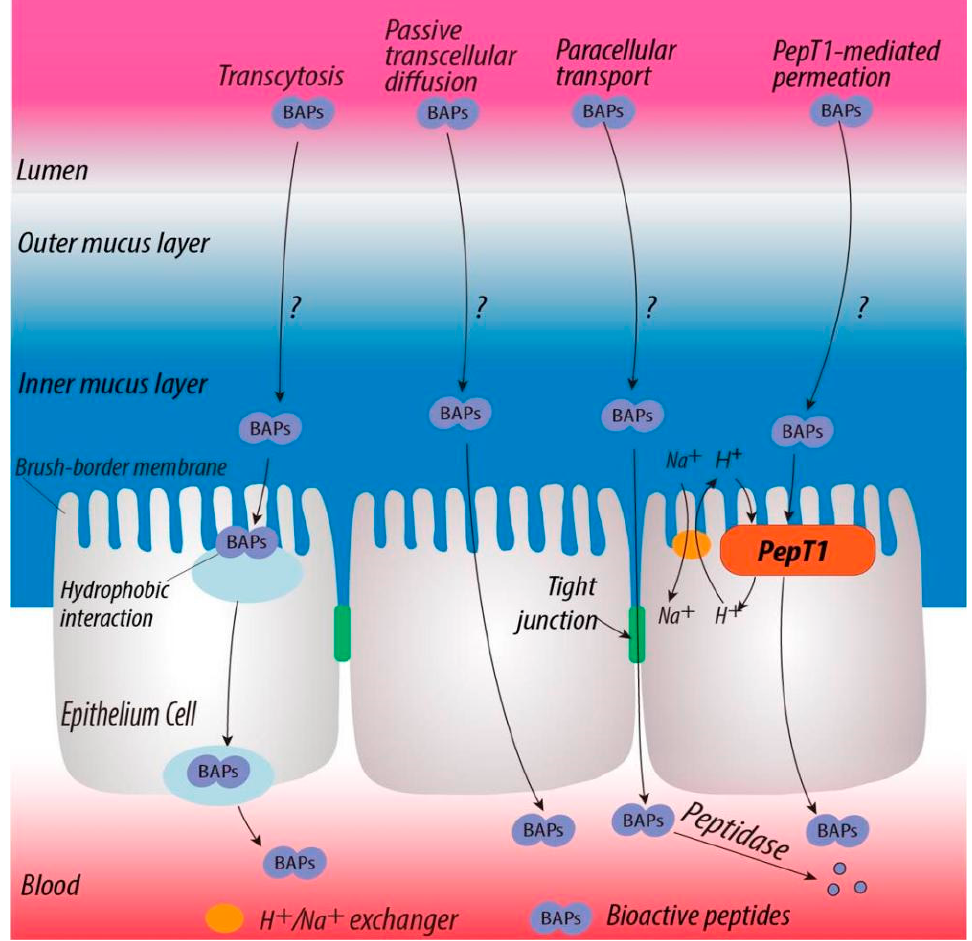
Figure 1. Plausible pathways for the transport of bioactive peptides across the gastrointestinal epithelium into the blood circulation, including PepT1-mediated permeation, paracellular transport via tight junctions, transcytosis, and passive transcellular diffusion. It is still not known how peptides interact with mucin and penetrate the mucus layers before transporting across the underlying epithelium. This figure was reprinted from [5] with permission from Elsevier.